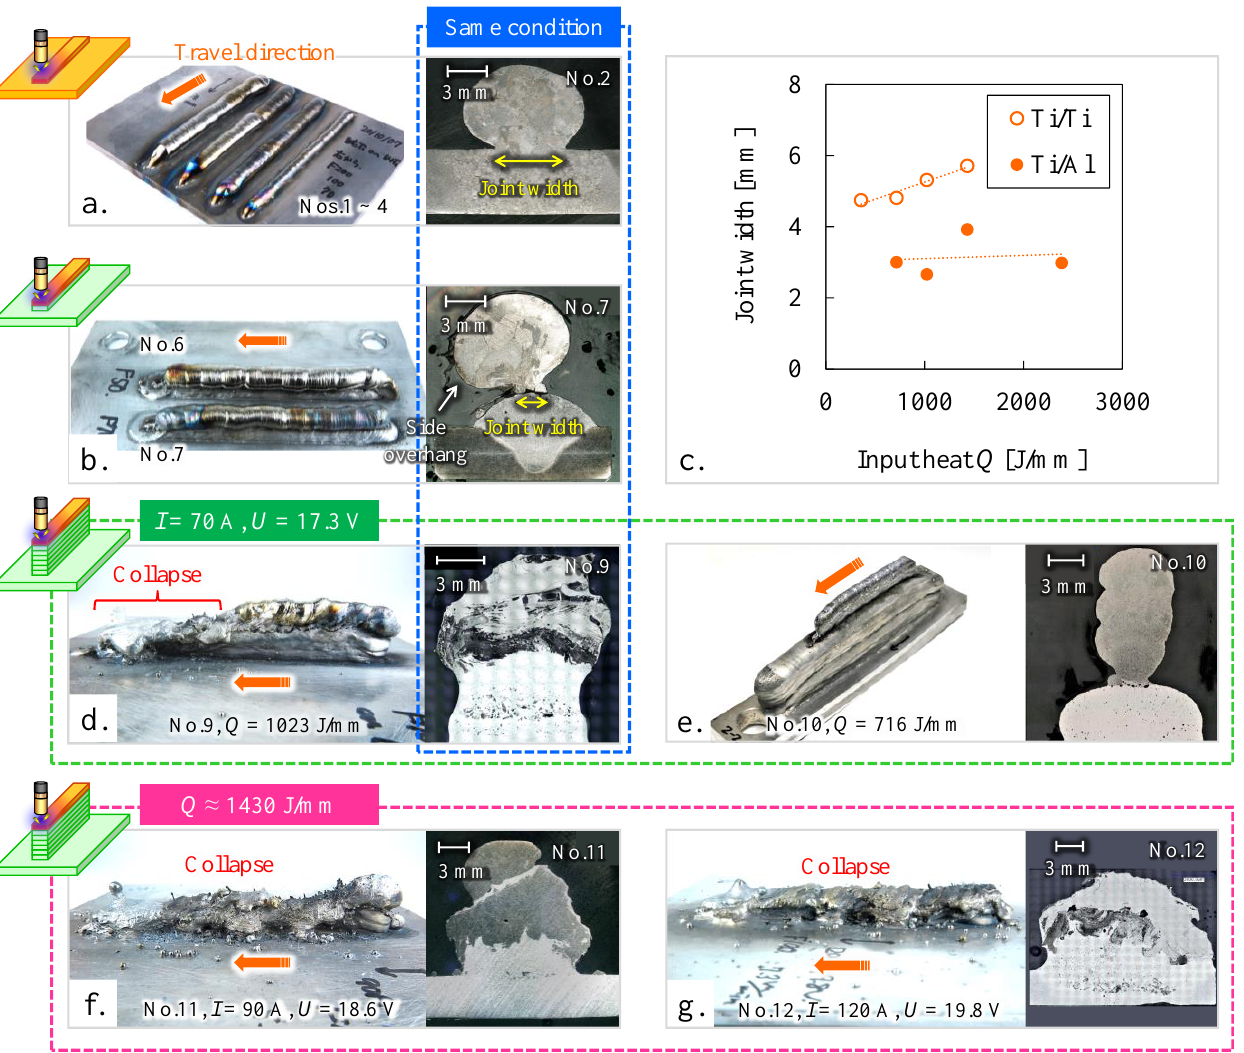
Figure 3. Appearance and cross-sectional views of Ti/Ti or Ti/Al components: Ti beads deposited onto ( a ) Ti substrate and ( b ) single Al alloy bead. ( c ) Comparison of Ti/Ti and Ti/Al joint widths. Ti beads deposited onto Al wall structures with the conditions of ( d ) No. 9 the same as No. 2 and 7; ( e ) No. 10 the same I and U , and lower Q than No. 9; ( f ) No. 11 with higher I , U , and Q than No. 9; and ( g ) No. 12 with higher I and U and same Q as No. 11.